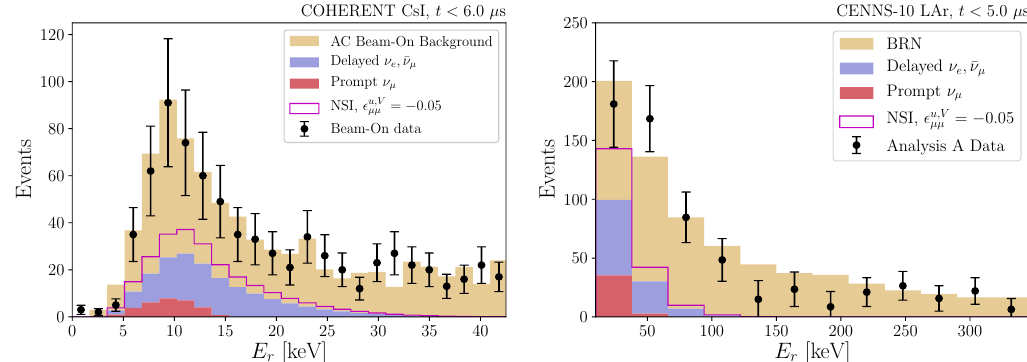
Figure 5 . The COHERENT CsI event spectra (left) and the CENNS-10 LAr event spectra from \Analysis A" (right) data is shown along with the standard neutrino interactions event rate predic- tion and BRN rates stacked together. Neutrino NSI event rates are separately shown for